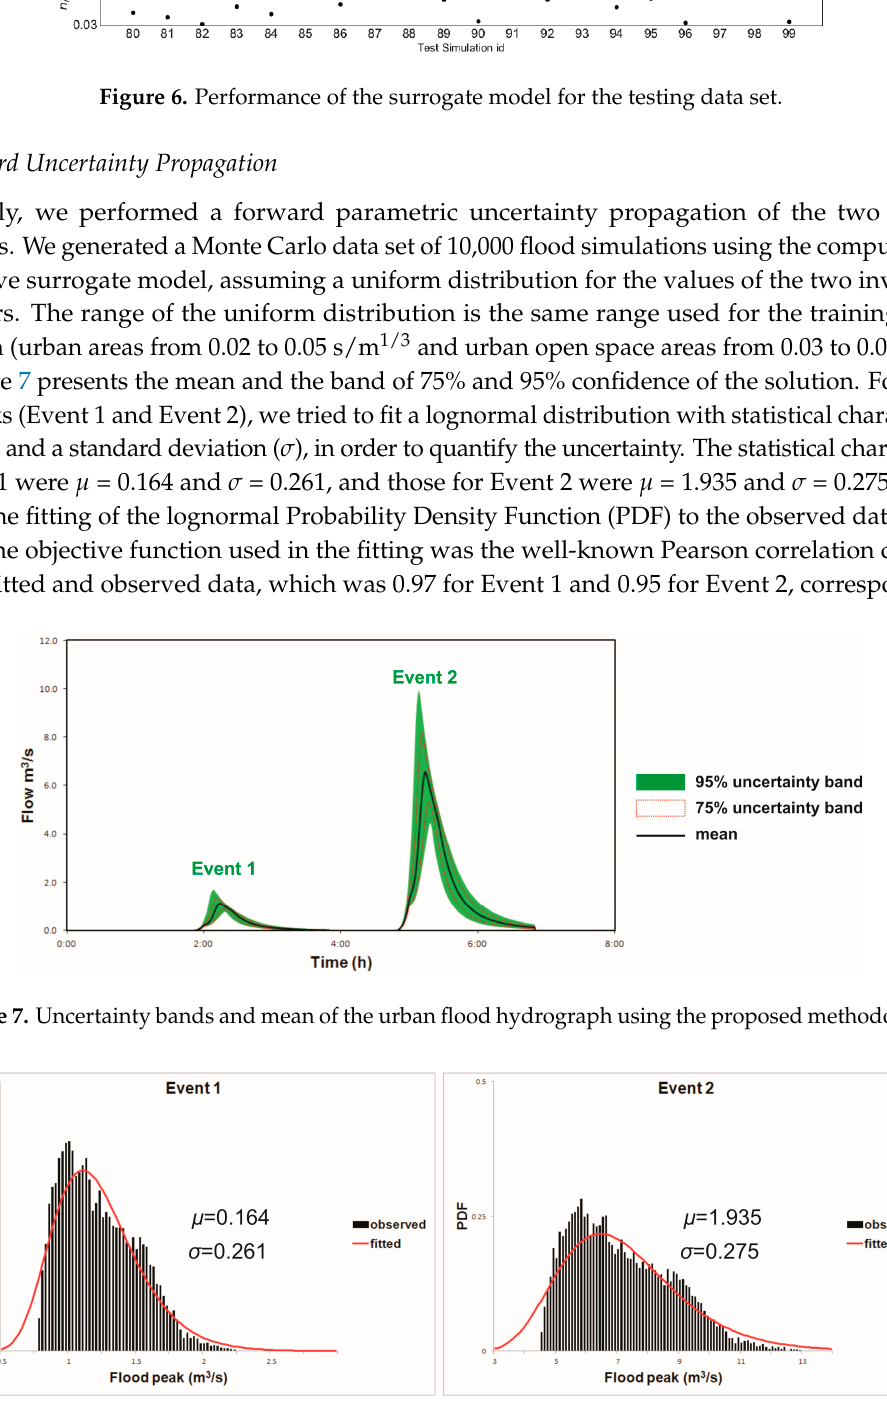
Figure 8. Probability Density Function (PDF) for observed and fitted flood peaks for Event 1 and Event 2.